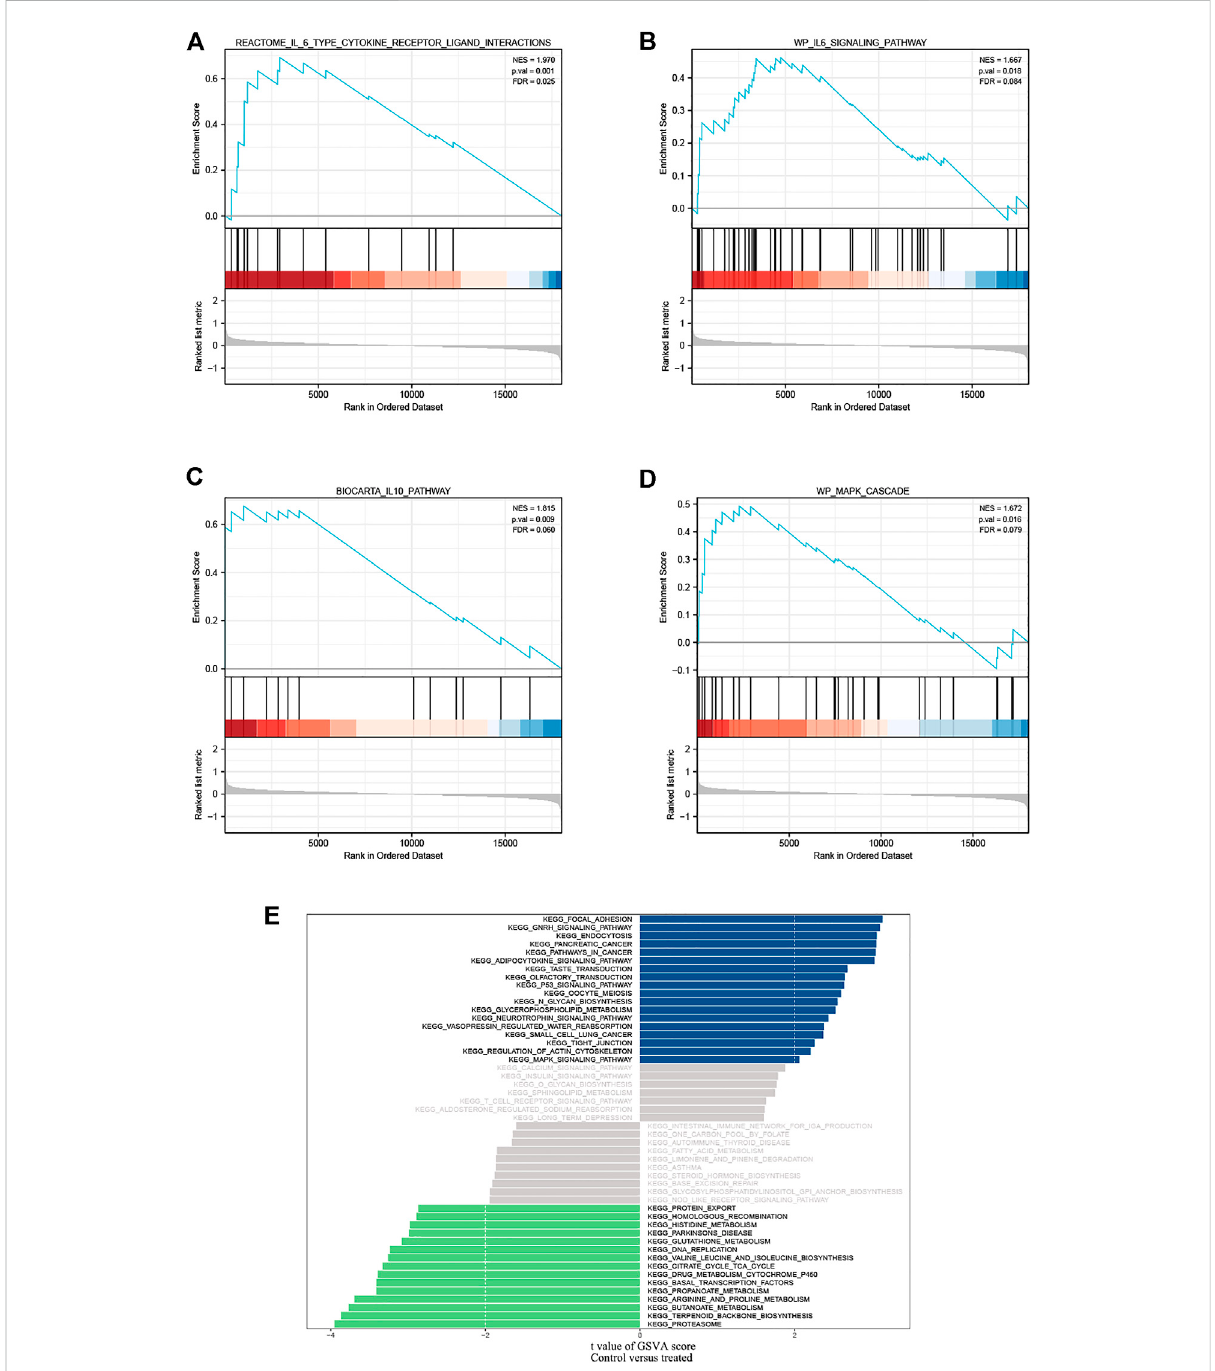
FIGURE 3 GSEAidenti fi edIL-6typecytokinereceptorligandinteractions. (A,B) IL-6familysignalingpathways; (C) IL-10pathwayand (D) MAPKcascadeas regulatory targets of paeoni fl orin in pancreatic cancer. (E) Differences in pathway activities scored per sample by GSVA between PF-treated group and control group. Blue represents the pathway with t value greater than 2, and green represents the pathway with t value less than -2. NES, normalized enrichment score; FDR, False discovery